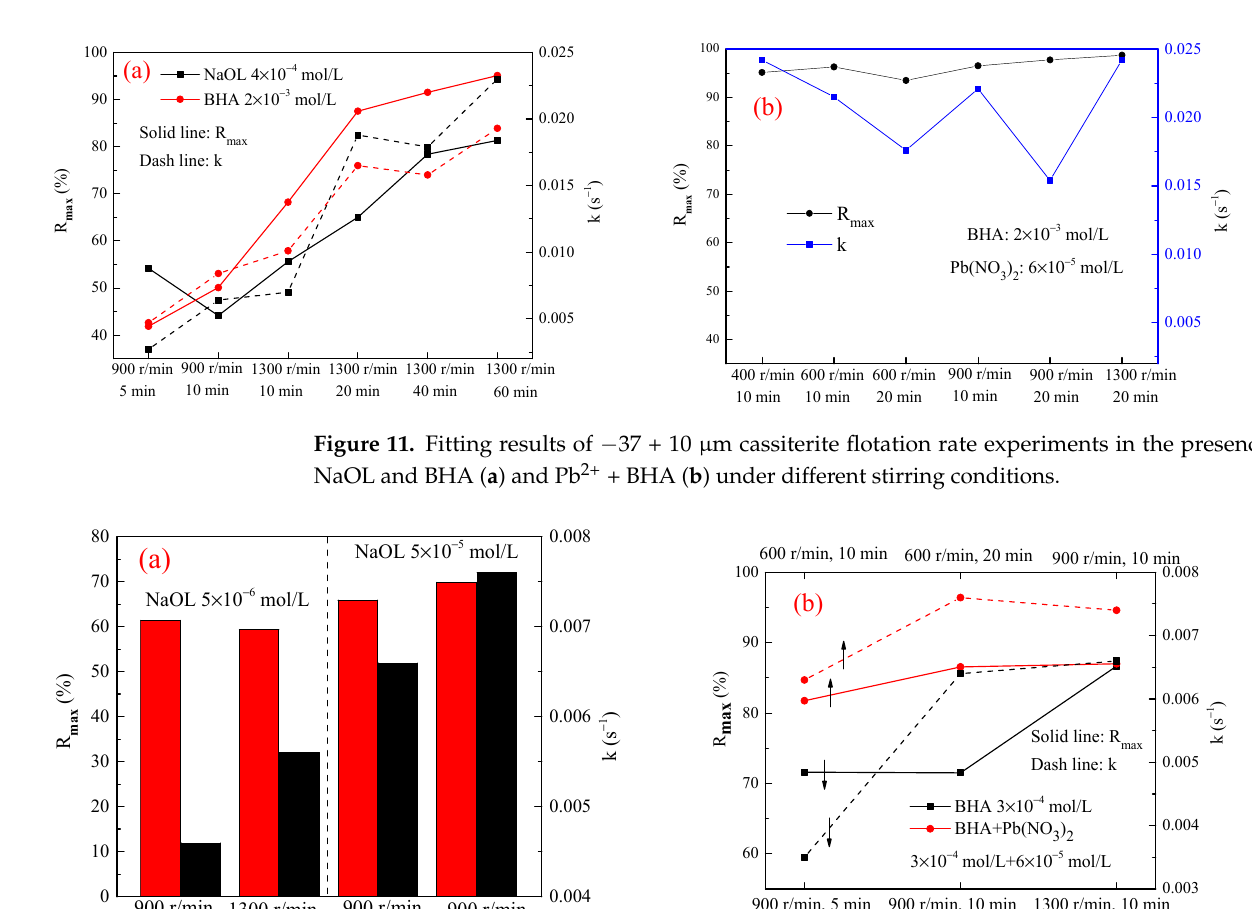
Table 2. Effect of stirring time on the flotation of Xintian − 37 µ m cassiterite. T (min)